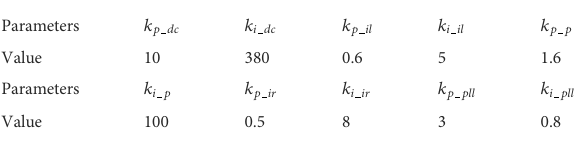
TABLE 6 Optimal parameter combination based on